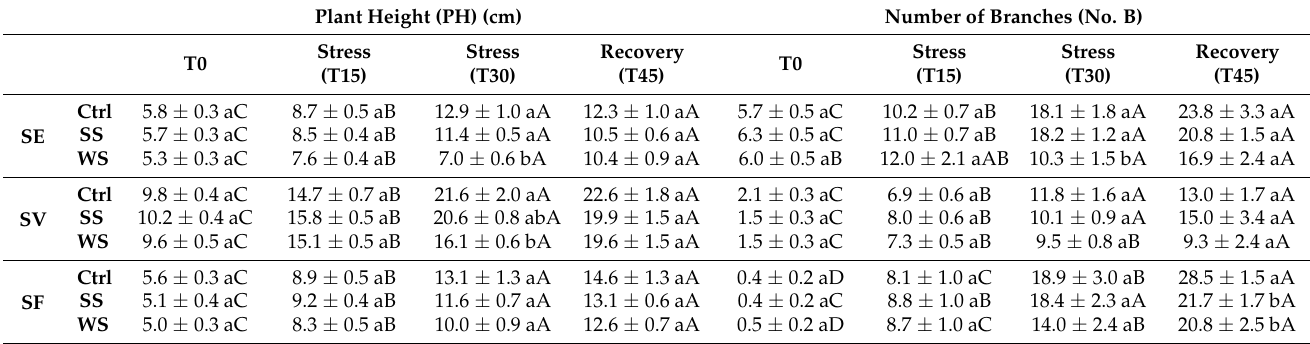
Table 1. Plant height (cm) and number of branches in the three halophytes (SE, S. europaea ; SV, S. veneta ; SF, S. fruticosa ) measured at the beginning (T0) and after 15 (T15), 30 (T30), or 45 (T45) days of starting the stress treatments. Ctrl, control; SS, salt stress (watering with 700 mM NaCl); WS, water stress (complete withholding of irrigation). The values shown are means ± SE ( n = 4). For each species, different lowercase letters in a column indicate significant differences between the three treatments within the same sampling time, whereas different uppercase letters in each row indicate significant differences between sampling times for the same treatment, at p ≤ 0.05.